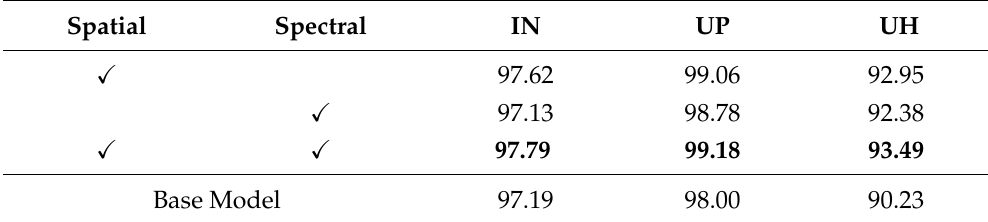
Table 4. Effect of spatial and spectral attention in DMuCA (OA%). (cid:88) denotes the corresponding attention block present in DMuCA. The best results are highlighted in bold